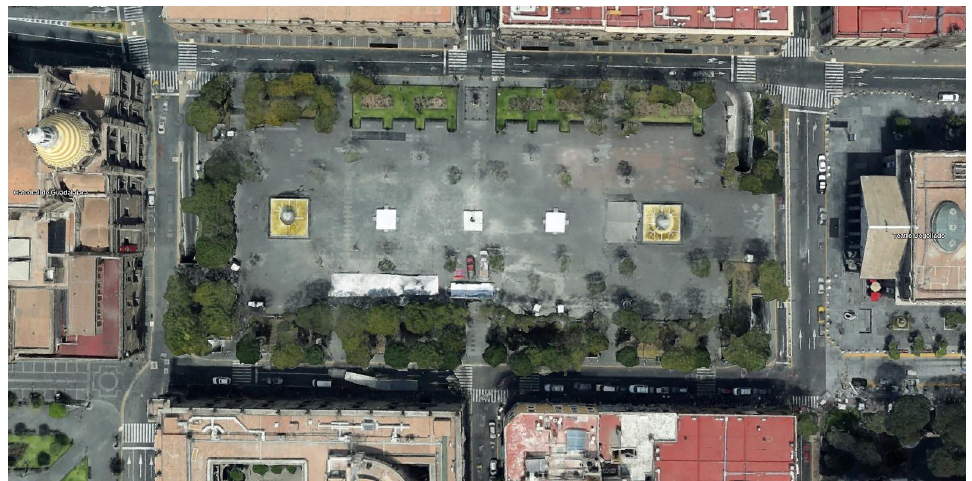
Figure 1. Satellite photo (Google Earth, 2022) of the domain Ω under study: Plaza Liberación in Guadalajara (Mexico), a rectangular square of approximately 180 by 92 m.